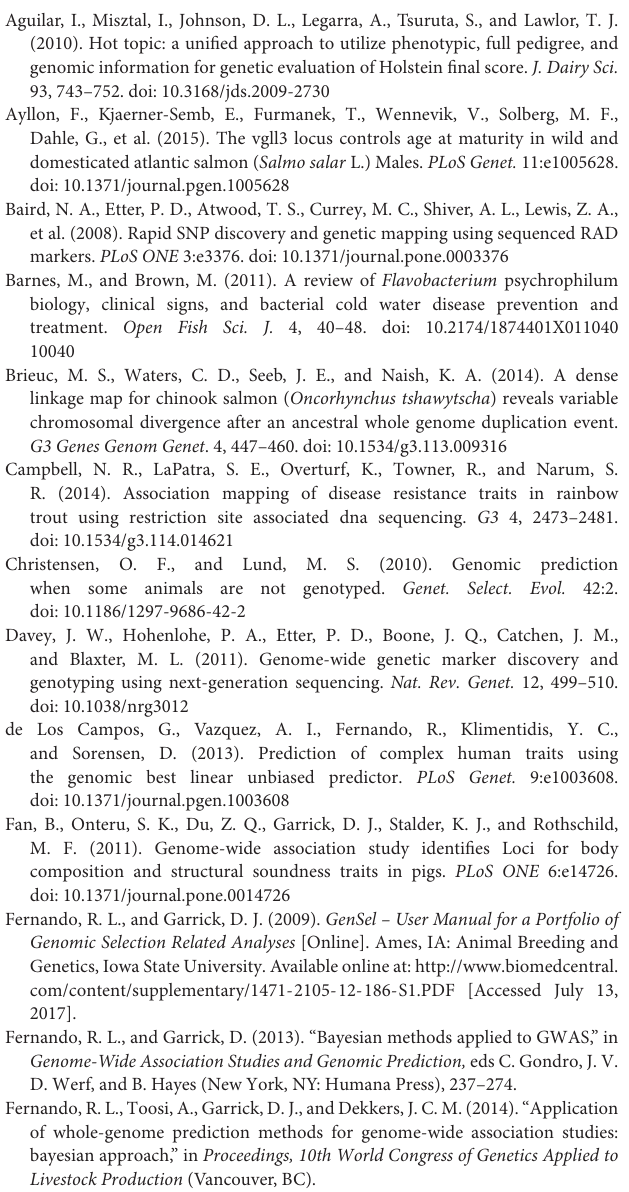
(A) GWAS for DAYS performed with BayesB using 1Mb exclusive windows. (B) GWAS for DAYS performed with wssGBLUP using 1Mb sliding windows. Figure S2 | Manhattan plot showing the association between SNP genomic windows and BCWD resistance in NCCCWA sample genotyped with 57K Chip-SNP: (A) GWAS for DAYS performed with BayesB using 1Mb exclusive windows. (B) GWAS for DAYS performed with wssGBLUP using 1Mb sliding windows. Figure S3 | Manhattan plot showing the association between SNP genomic windows and BCWD resistance in NCCCWA sample genotyped with the RAD-SNPs: (A) GWAS for DAYS performed with BayesB using 1Mb exclusive windows. (B) GWAS for DAYS performed with wssGBLUP using 1Mb sliding